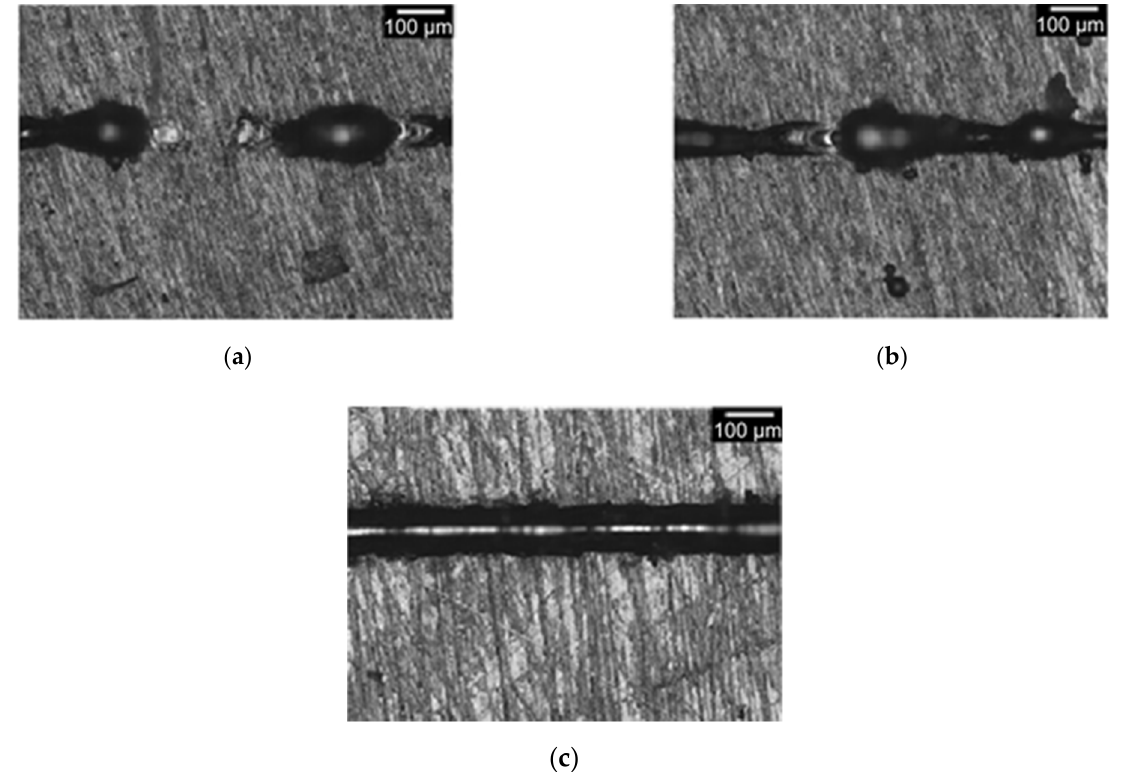
Figure 2. Optical Micrographs of “irregular” SSTs ( a – b ) and a “regular” SST ( c ).